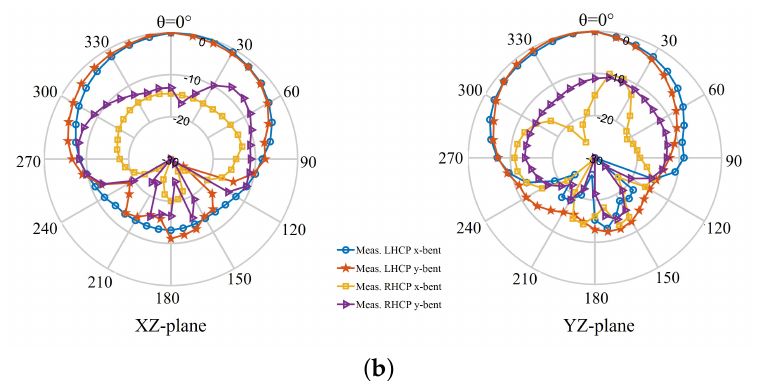
Figure 27. Simulated and measured far-field radiation patterns of the transparent antenna at 2.4 GHz: